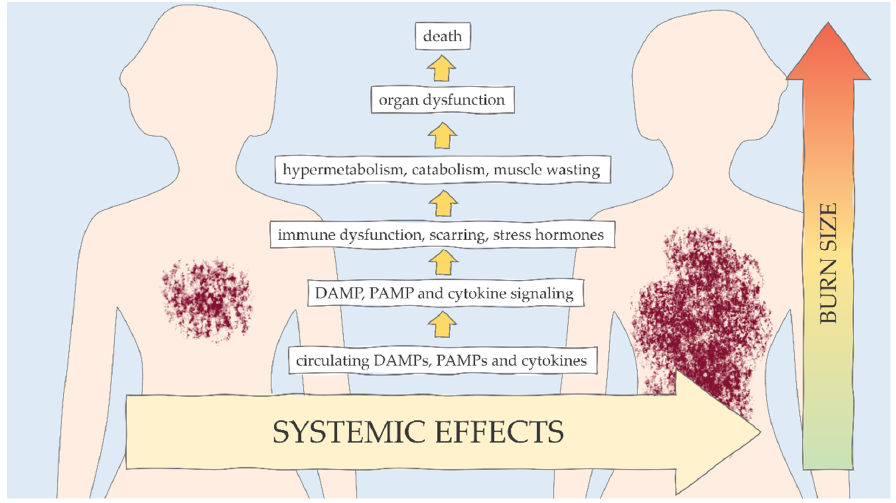
Figure 1. Systemic responses are dependent on the size of the burn (based on [1–4]).